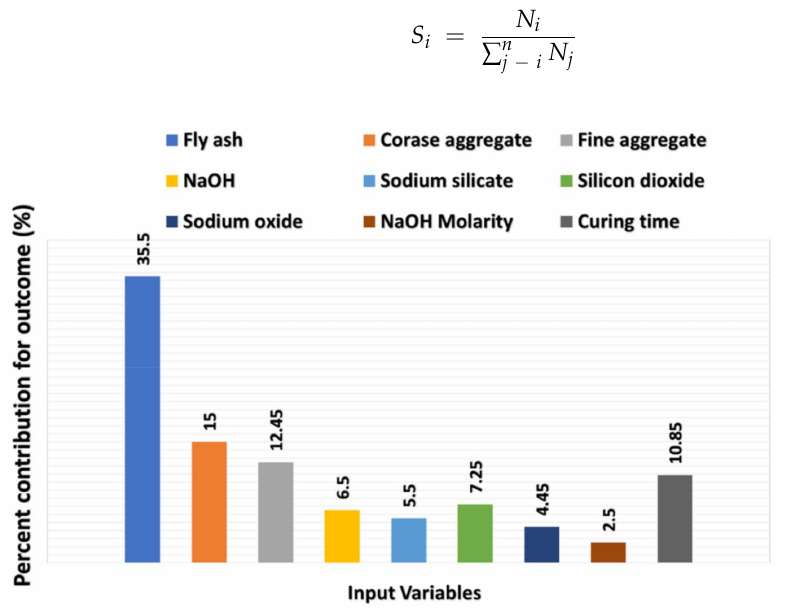
Figure 12. Contribution level in percentage towards the predicted